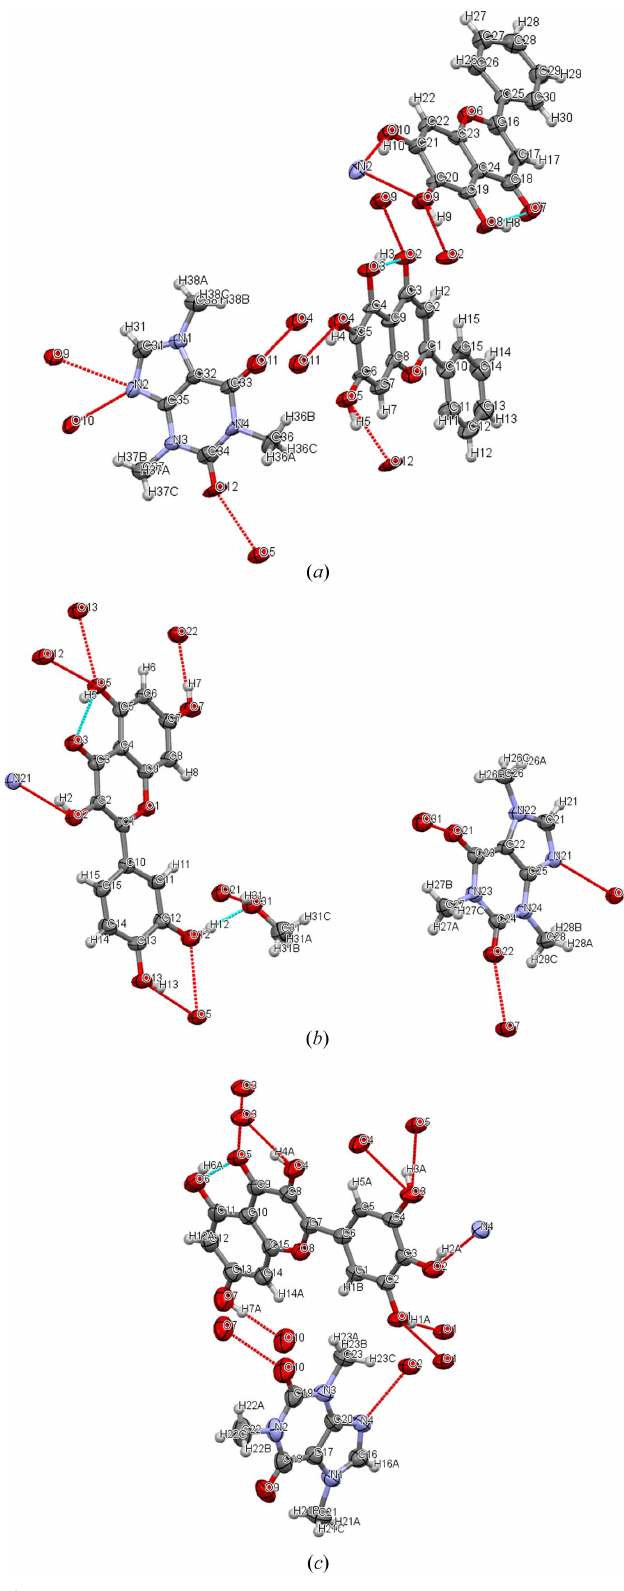
Figure 4 Schematic motif of the cocrystals with hydrogen bonds ( a ) BAI–CAF, ( b ) QUE–CAF (cid:9) MeOH, ( c ) MYR–CAF. Hydrogen bonds between molecules forming heterodimers are indicated by red lines, and blue dashed lines represent the inter- and intramolecular hydrogen bonds of the